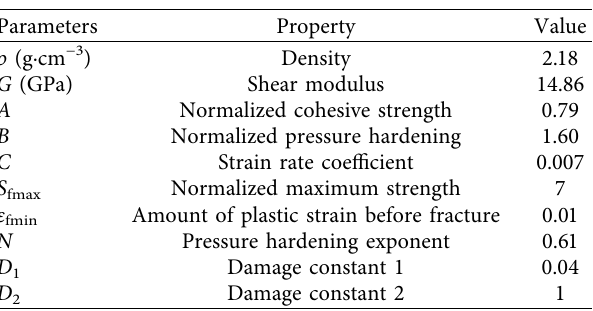
Table 3: Material parameters of rock [23].